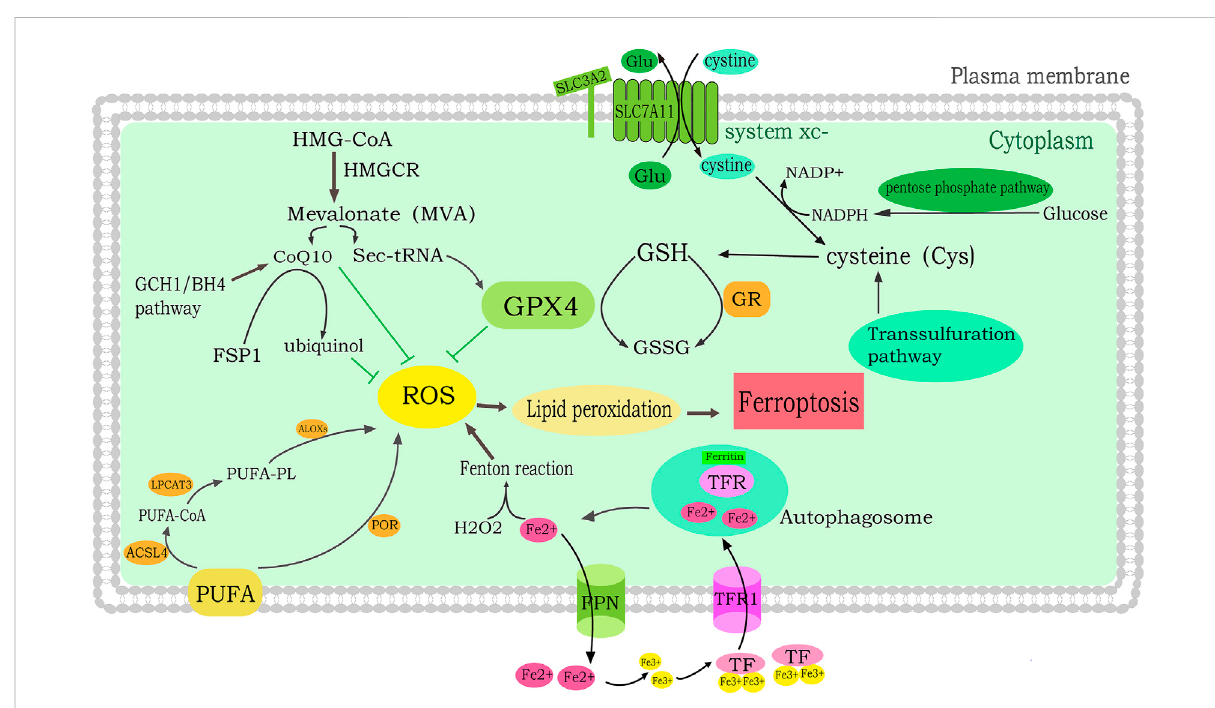
FIGURE 1 Molecular mechanisms of ferroptosis in breast cancer. lipid peroxidation leads to ferroptosis. PUFA is catalyzed by LPCAT3, ACSL4 and LOX to generate PUFA-PLOOH, which induces ferroptosis. In addition, PUFAs also promote ferroptosis through POR-mediated conversion to lipid peroxides.The MVApathway suppresses ROS byregulating Sec-tRNAand CoQ10. Theiron mediates ferroptosis. FPN regulates theintracellular iron level by converting Fe 2+ to extracellular iron. TF binds to the TFR to convert Fe 3+ to Fe 2+ and enter cells. Free Fe 2+ then induces the lipid ROS production by Fenton